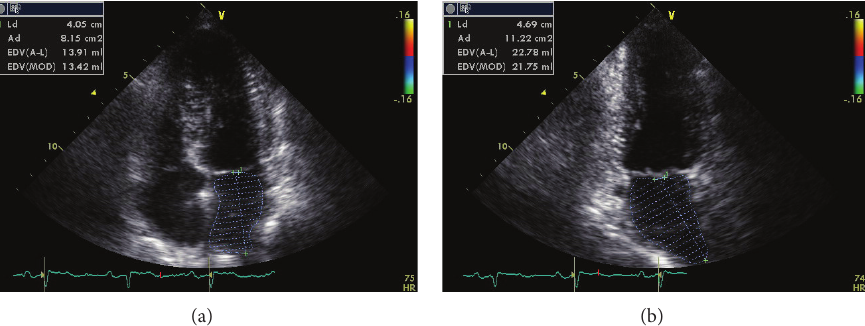
Figure 3: Measurement of left atrial volume from biplane method of disks (modified Simpson’s rule) using apical 4-chamber (a) and apical 2-chamber (b) views at ventricular end-systole (maximum